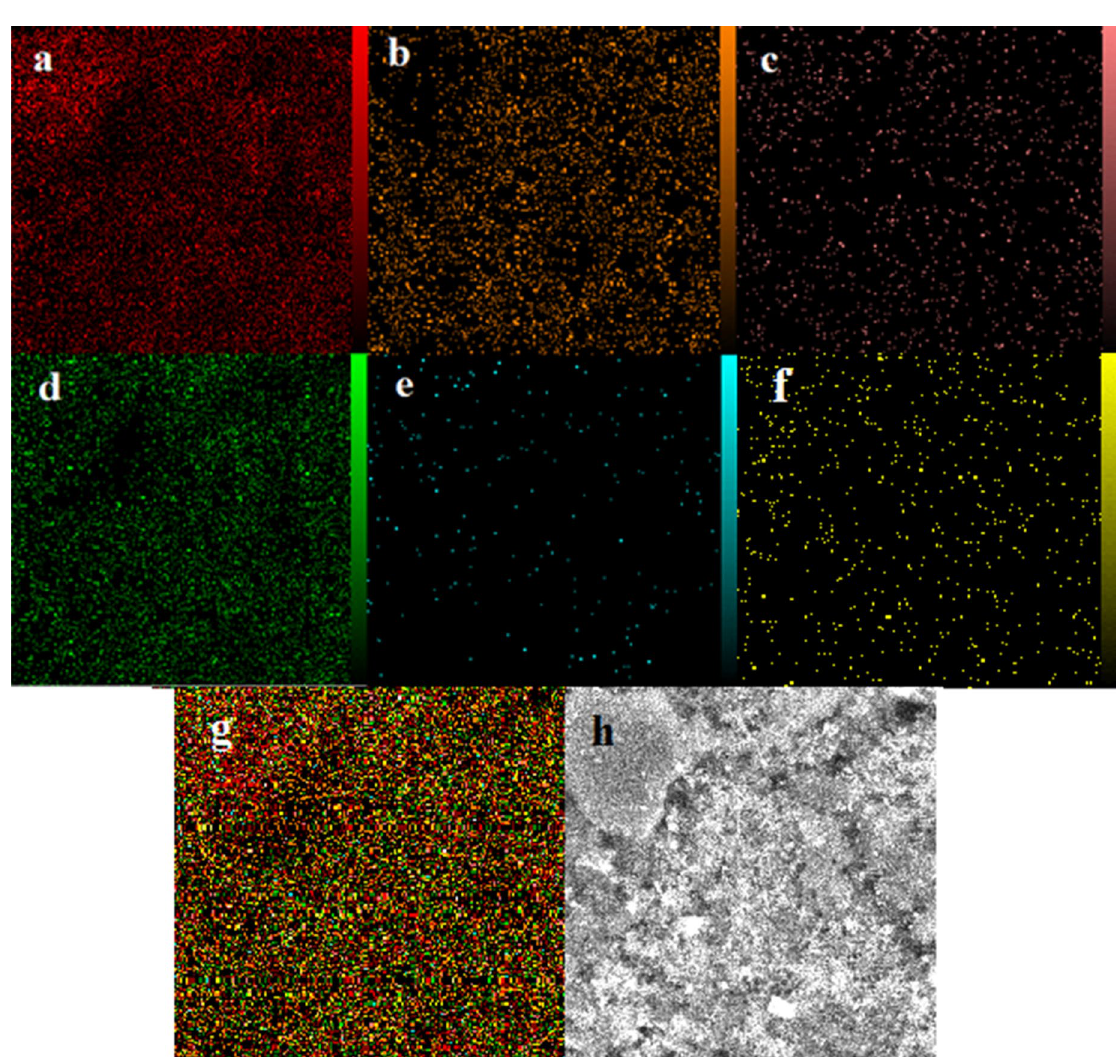
Figure 6. EDX-Mapping of the C (a) , Fe (b) , N (c) , O (d) , Zn (e) , Mg (f) , ZIF-8/GO/MgFe 2 O 4 /TC (g) , SEM images in 10 μm (h)